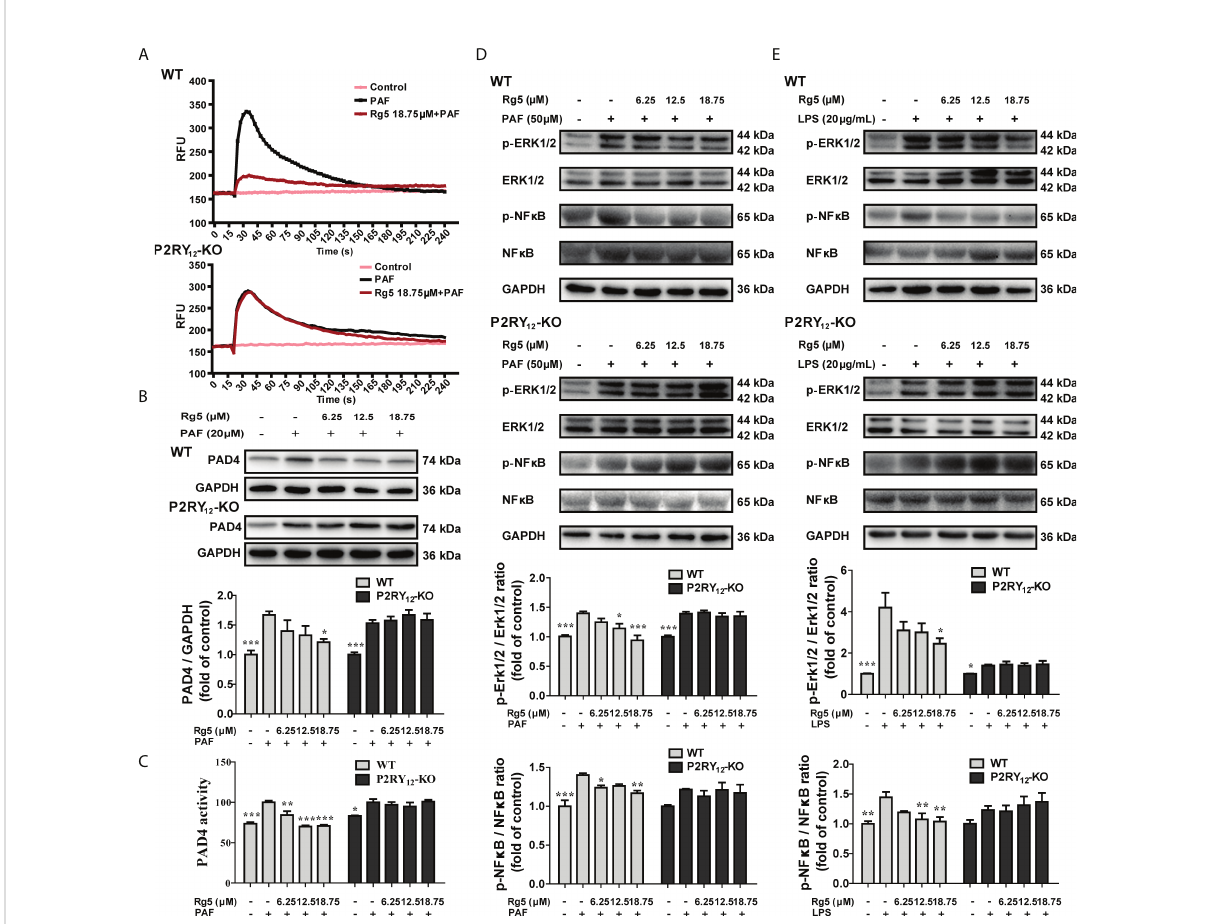
FIGURE 6 Effects of Rg5 on PAF or LPS-induced activation of PAD4 and ERK/NF- k B signaling pathway in WT or P2RY 12 -KO neutrophils. (A) Calcium fl ux in WT or P2RY 12 -KO neutrophils stimulated by PAF (n = 3). (B) Protein expression of PAD4 in WT or P2RY 12 -KO neutrophils stimulated by PAF (n = 5). (C) Activity of PAD4 in WT or P2RY 12 -KO neutrophils stimulated by PAF (n = 4). (D, E) Western Blot results and statistical analysis of protein expression and phosphorylation levels of ERK (n = 5) and NF- k B (n = 5) in WT or P2RY 12 -KO neutrophils stimulated by PAF or LPS. All the data are shown as the mean ± SEM. * P < 0.05, ** P < 0.01, *** P < 0.001 vs. PAF or LPS